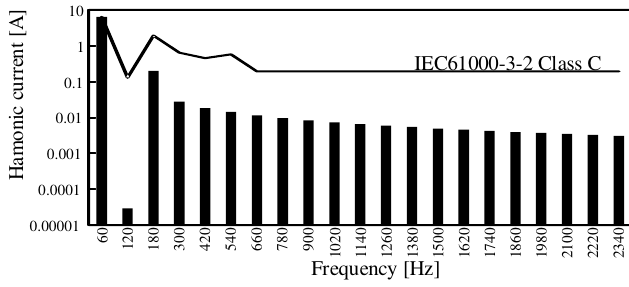
is changed from 15 mA to 1.5 A. LED